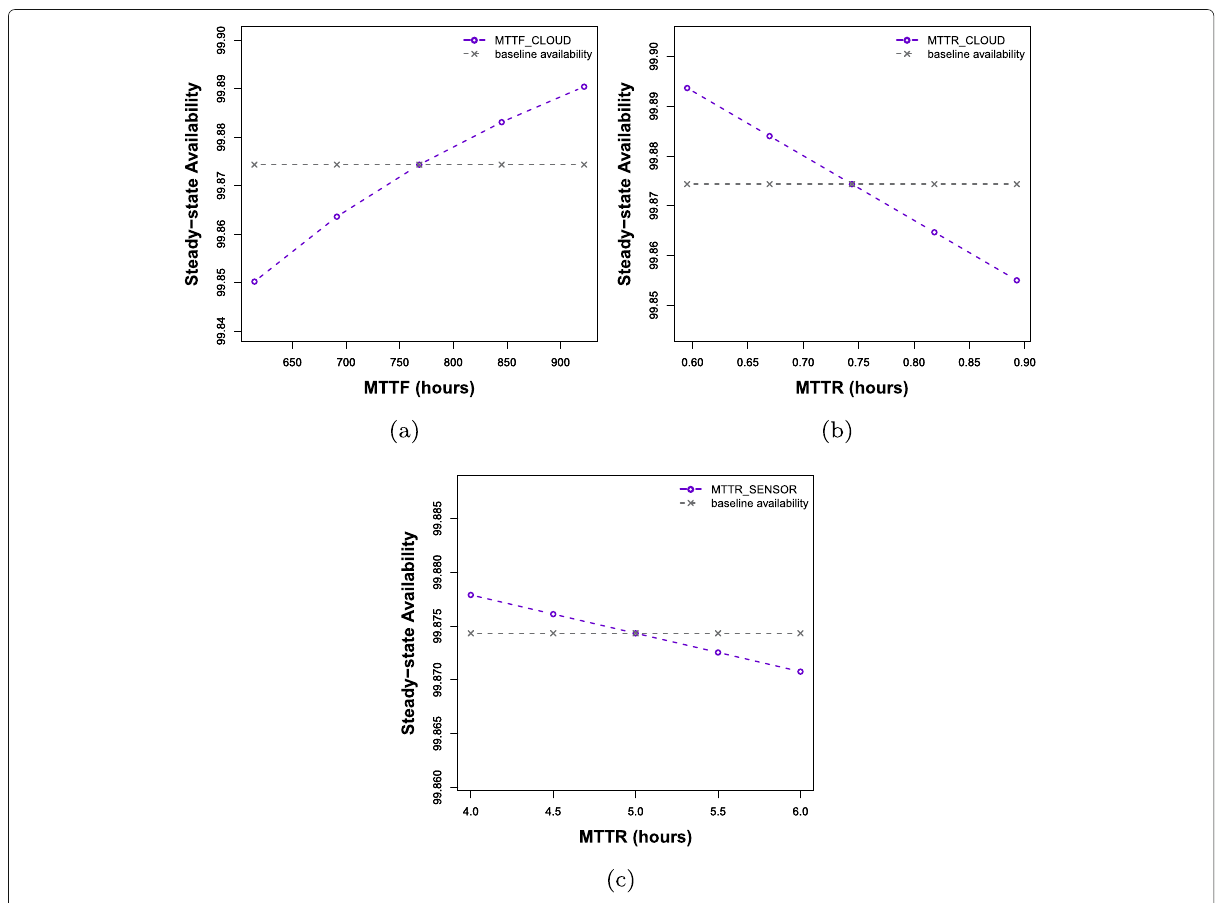
Fig. 15 Availability results of scenario 2 varying a the cloud MTTF, b the cloud MTTR and c , the sensor MTTR